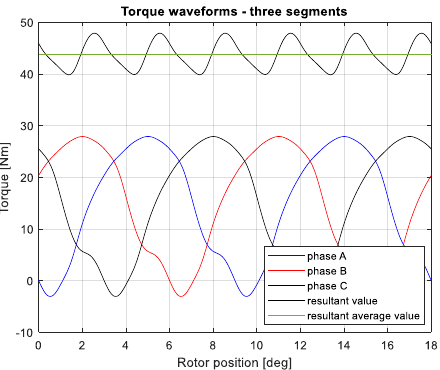
Figure 10. Torque waveforms for three segments and their resultant values.